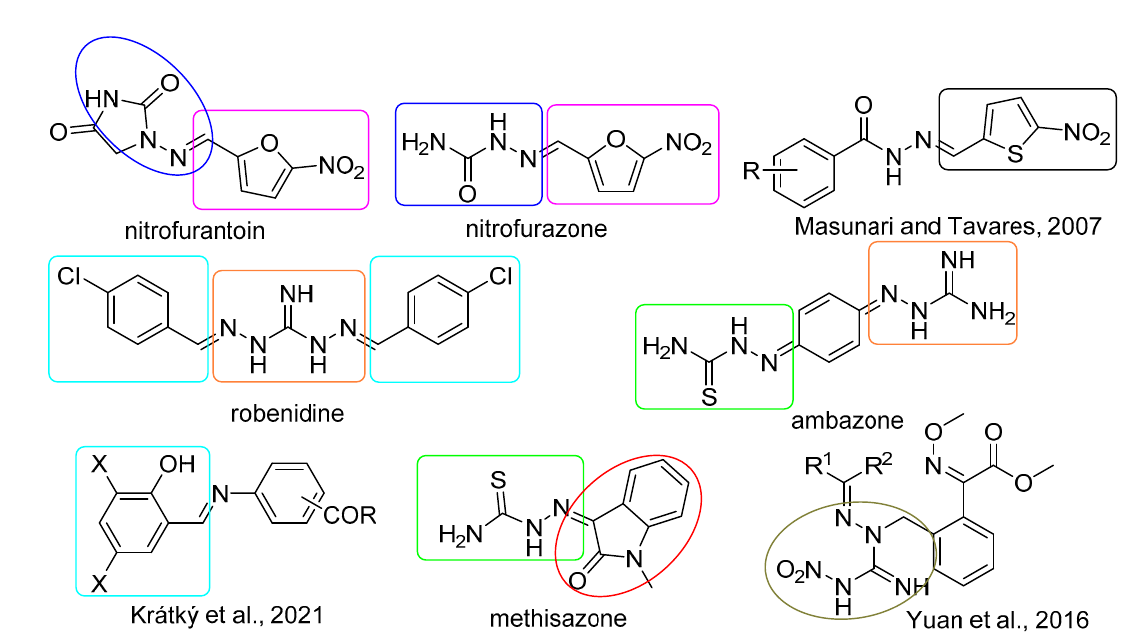
Figure 1. Structural motifs of known bioactive compounds used for design of targeted derivatives (aminoguanidine and 1,3-diaminoguanidine; nitroaminoguanidine; semicarbazone; thiosemicarbazone; 5-nitrofurylidene; (5-nitrothiophen-2- yl)methylidene; halogenobenzylidene; isatin).